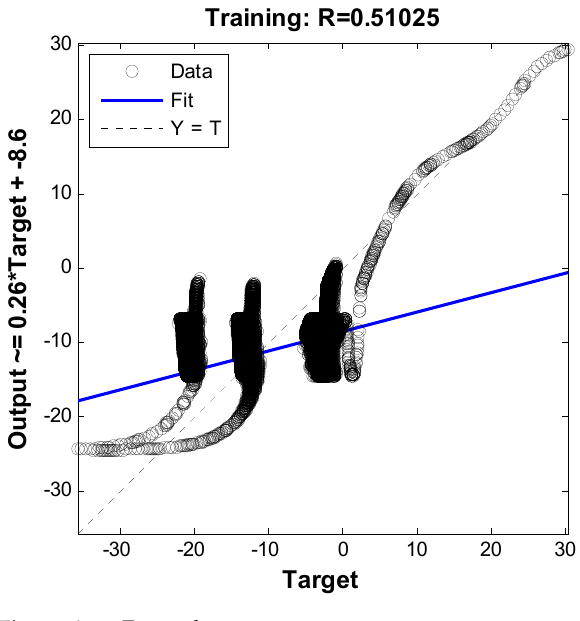
Figure A12. Error plot.